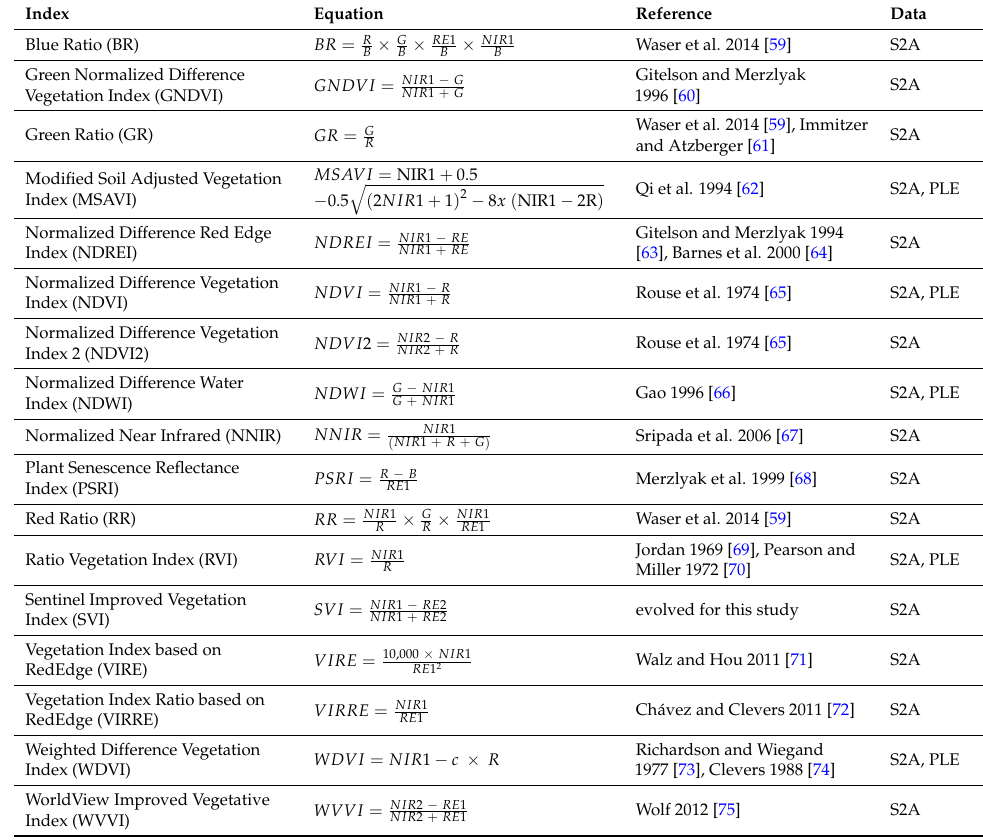
Table 5. Overview of the calculated vegetation indices (VI) used for the classification. The table includes name, abbreviation, equation, references and dataset on which it was applied. PLE: Pléiades and S2A: